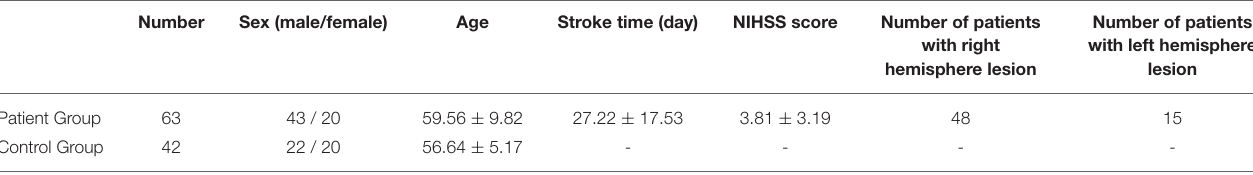
TABLE 1 | Demographic features and clinical information of patients with stroke and normal controls.